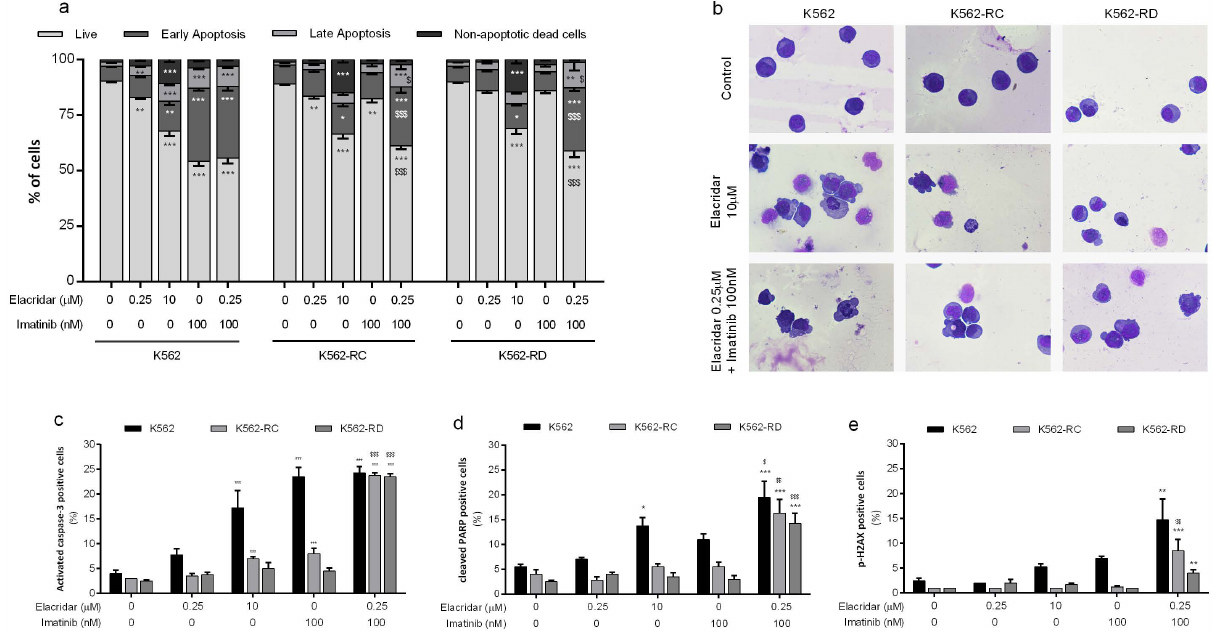
Figure 4. Analysis of cell death induced by elacridar as monotherapy and in combination with imatinib in CML cell lines. ( a ) The type of cell death was identified by annexin V/7-AAD staining and analyzed by flow cytometry; data were expressed as a percentage (%) of live, early apoptotic, late apoptotic/, and non-apoptotic cell death. In ( b ), cell morphology was analyzed in smears stained with May-Grünwald–Giemsa (amplification: 500 × ). The expression levels of activated caspase-3 ( c ), cleavage PARP ( d ), and phosphorylated-H2AX ( e ) were determined by flow cytometry as markers of apoptosis and DNA damage. Results were obtained after 48 h of incubation and represent mean ± SEM of at least four independent experiments. * p < 0.05; ** p < 0.01; *** p < 0.001 (comparison with control); $ p < 0.05, $$ p < 0.01; $$$ p < 0.001 (comparison with lower dose of correspondent